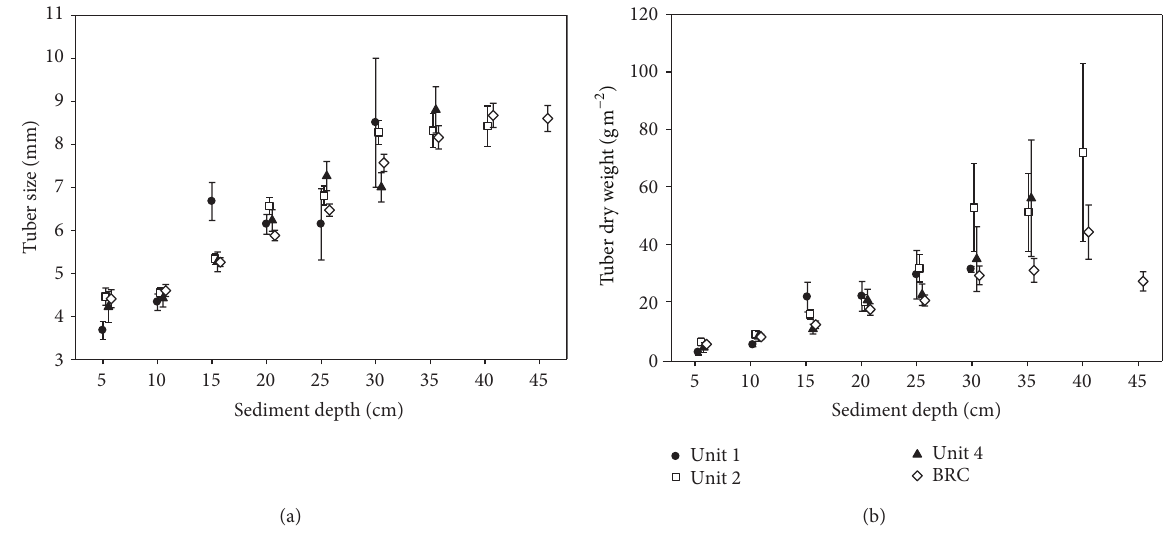
Figure 2: Tuber length (a; mean ± 1SE) and tuber dry mass (b; mean ± 1SE) per 5cm depth increments (e.g., values at 5 cm depth represent tubers found in 0–5 cm sediment depth) for the four study wetlands. Maximum sediment to a calcium hardpan differed among wetlands, with BRC being the wetland with the deepest sediments.